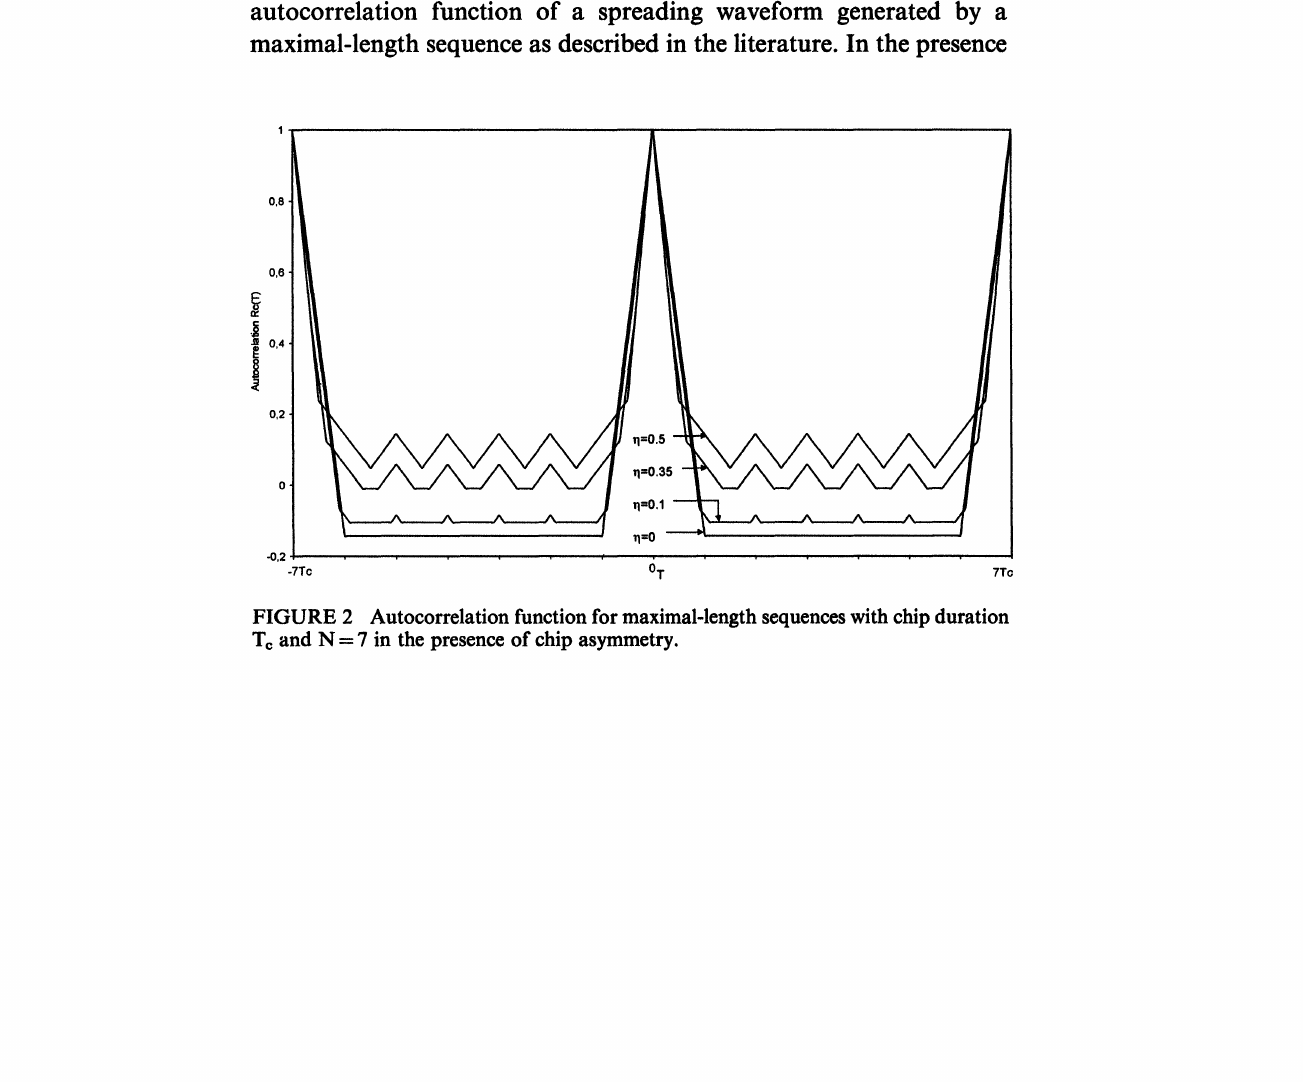
FIGURE 2 Autocorrelation function for maximal-length sequences with chip duration Te and N 7 in the presence of chip